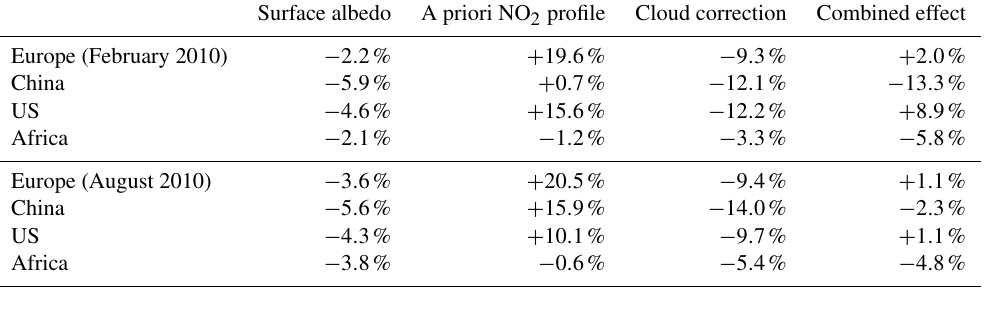
Table 3. Individual changes and the combined effect of our improved AMF calculation on the tropospheric NO 2 columns relative to the reference retrievals for western Europe (44–53 ◦ N, 0–7 ◦ E), eastern China (21–41 ◦ N, 110–122 ◦ E), the eastern US (30–45 ◦ N, 70–90 ◦ W), and central Africa (5–15 ◦ S, 10–30 ◦ E).